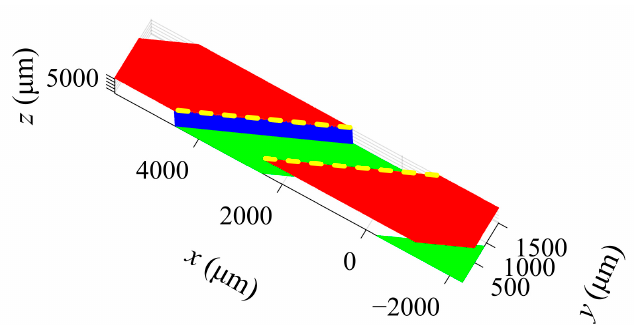
Figure 9. Mapped to Cartesian coordinate system.